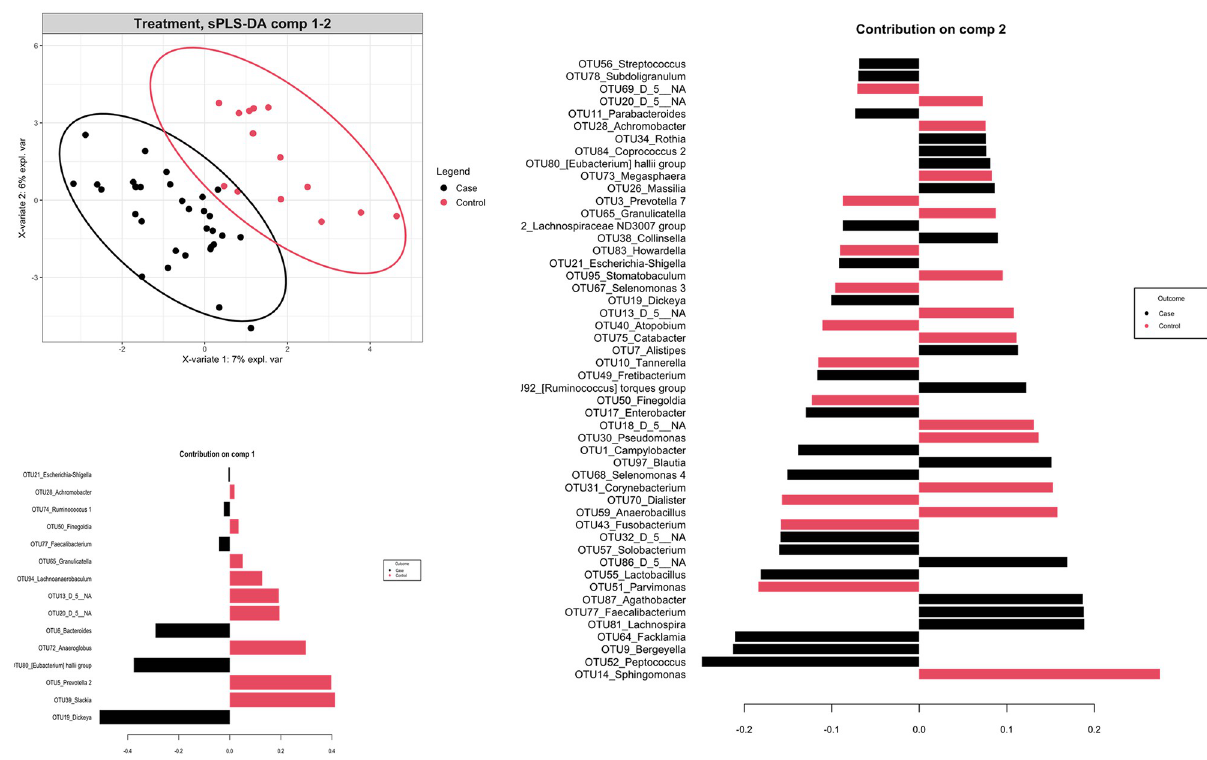
Fig 3. Multivariate analysis and diversity of biliary microbiota in patients with malignant (case) vs benign (control) pancreaticobiliary diseases using mixMC.